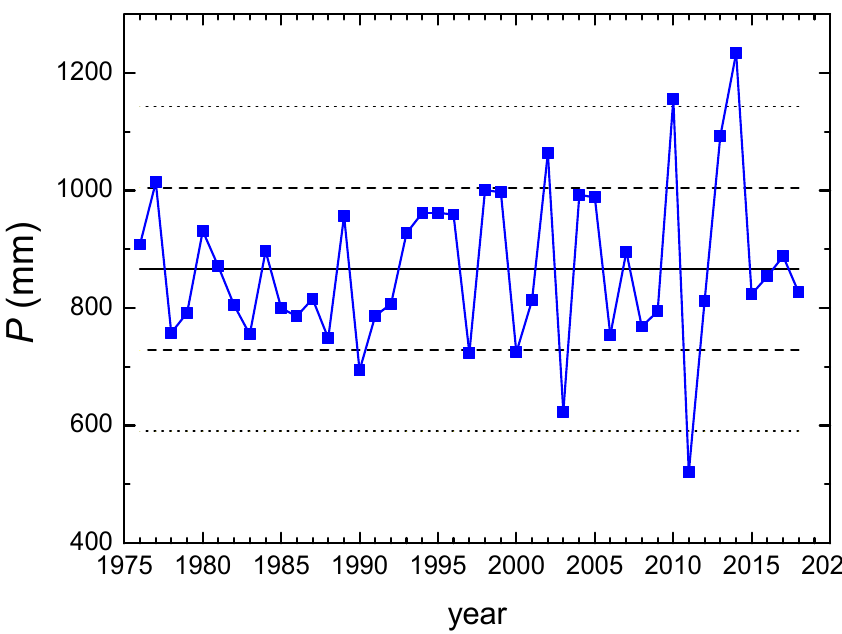
Figure 6. Annual precipitation amount P in Zagreb, 1976–2018 period. Solid line: the mean value for the whole period; dashed lines: ± 1 σ ; dotted lines: ± 2 σ . Table 2. Comparison of mean values of meteorological parameters ( T , P ) and isotopic data ( δ 18 O, δ 2 H, and d -excess) for different periods.